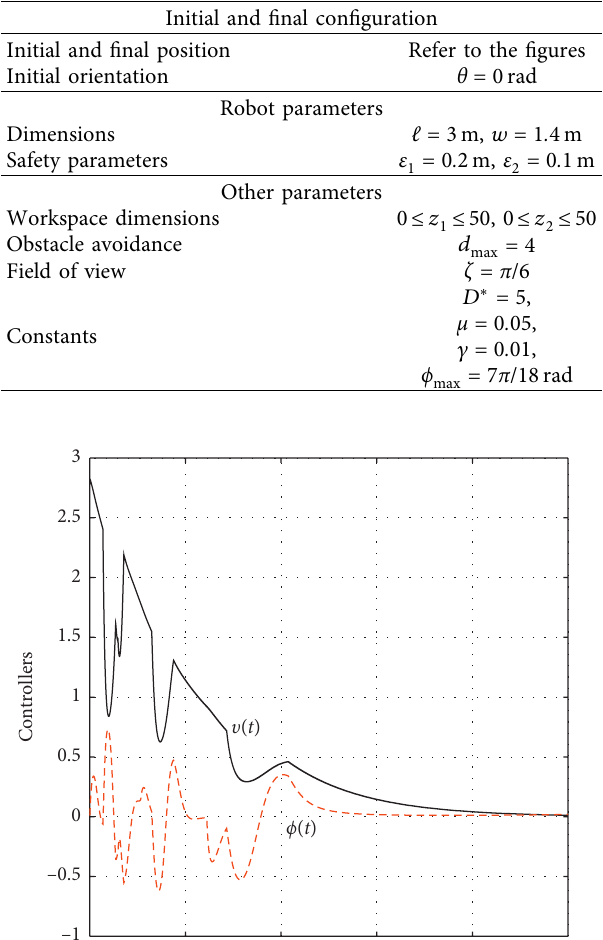
Table 1: Values of the parameters used in the simulations.